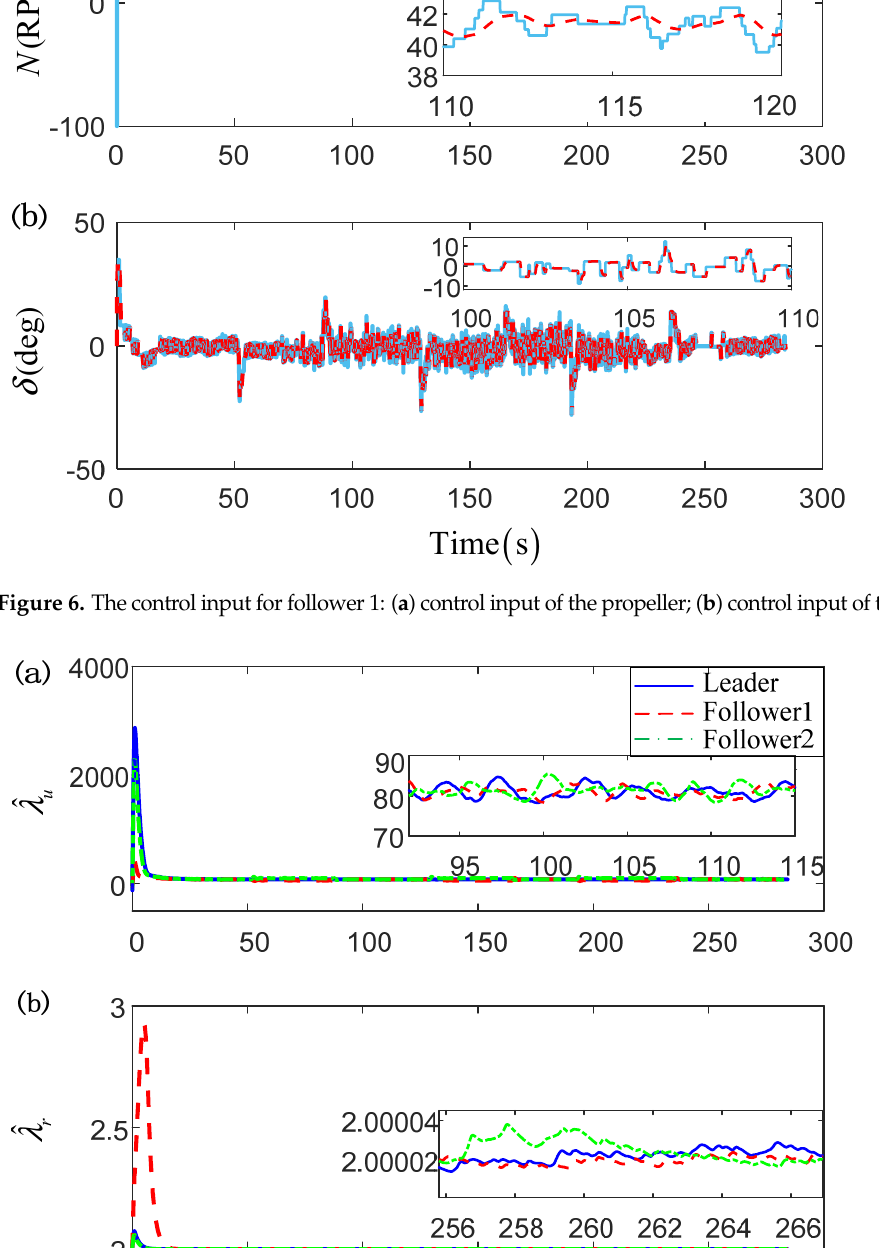
Figure 7. The composite adaptive parameters for USVs: ( a ) adaptive parameters for surge motion; ( b ) adaptive parameters for yaw motion.